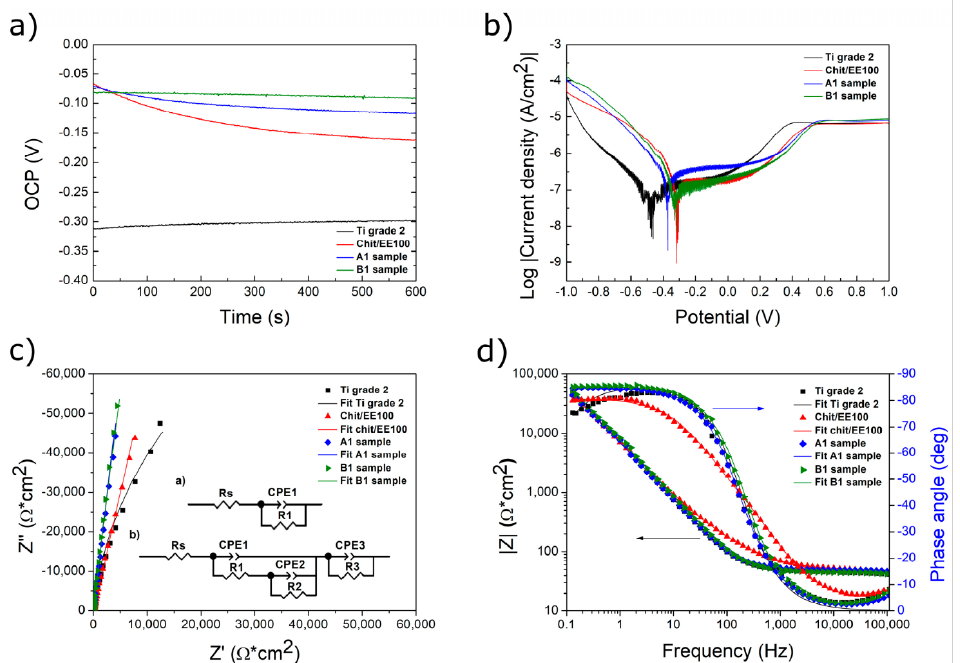
Figure 8. The results of electrochemical tests: ( a ) open circuit potential (OCP), ( b ) potentiodynamic polarization curves, and the experimental and simulated ( c ) Nyquist graphs with the equivalent circuit used to simulate experimental impedance data (( a )—for bare Ti grade 2 substrate, ( b )—for prepared coatings), and ( d ) Bode-Z and Bode-phase graphs of the bare titanium substrate, the chit/EE100 coating, and chit/EE100/AgNPs coatings (A1 and B1 samples) immersed in the SBF at 37 ◦ C.